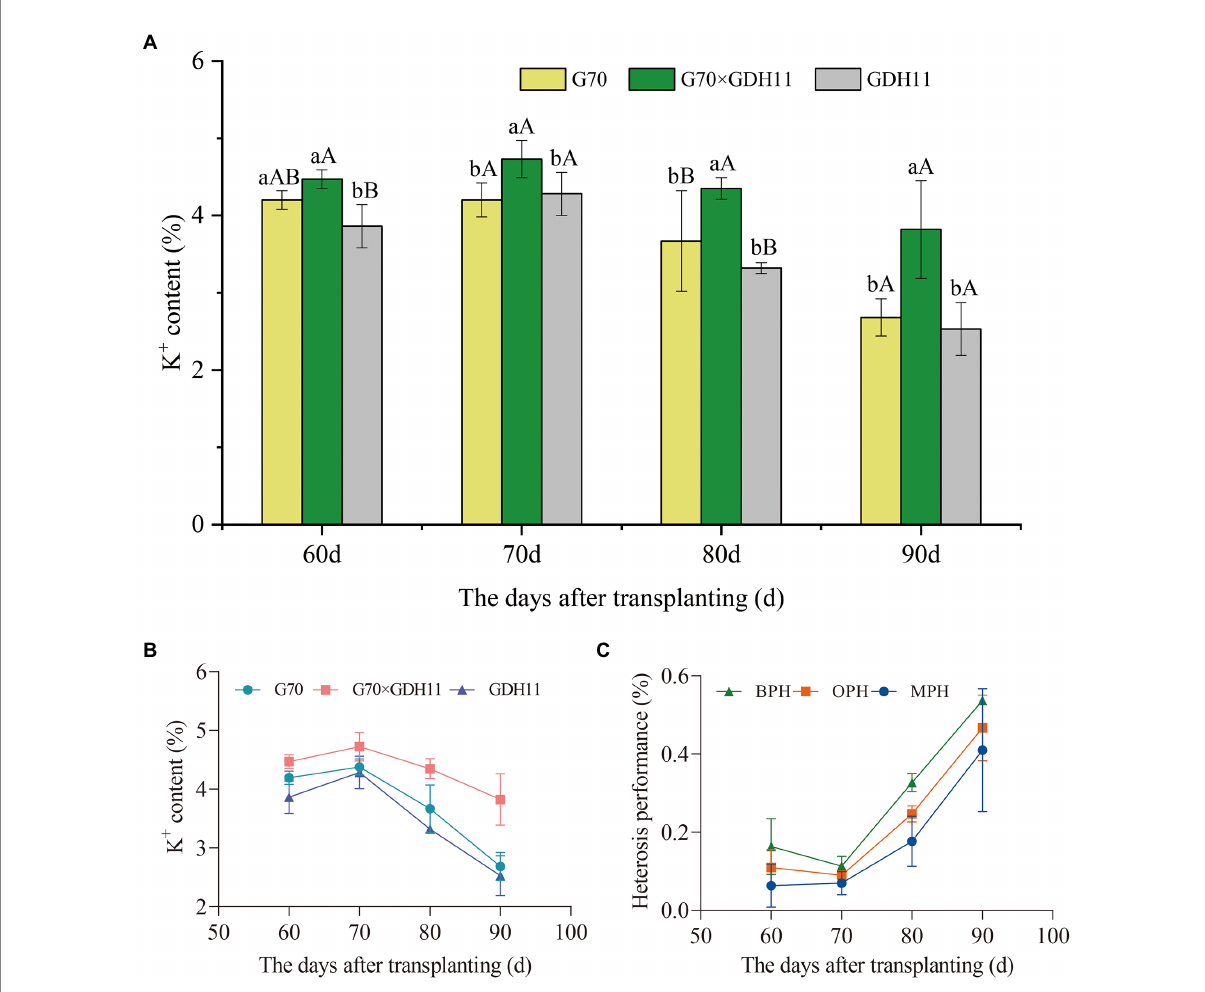
FIGURE 1 Potassium content of tobacco hybrids and their parents. (A) The K + content of the hybrid G70 × GDH11 and its parents G70 and GDH11. (B) The changes in the K + content in hybrid F 1 and its parents between 60 and 90 days after transplantation. (C) The heterosis performance values of the hybrid G70 × GDH11. The average value of three biological replicates per material was used for mapping. Error bars represent significant differences among the three replicates. Significant differences in the K + content at p < 0.05 and p < 0.01 were determined using Duncan’s new multiple range tests. The lowercase alphabets represent a significant difference ( p < 0.05), while the uppercase alphabets represent a highly significant difference ( p <